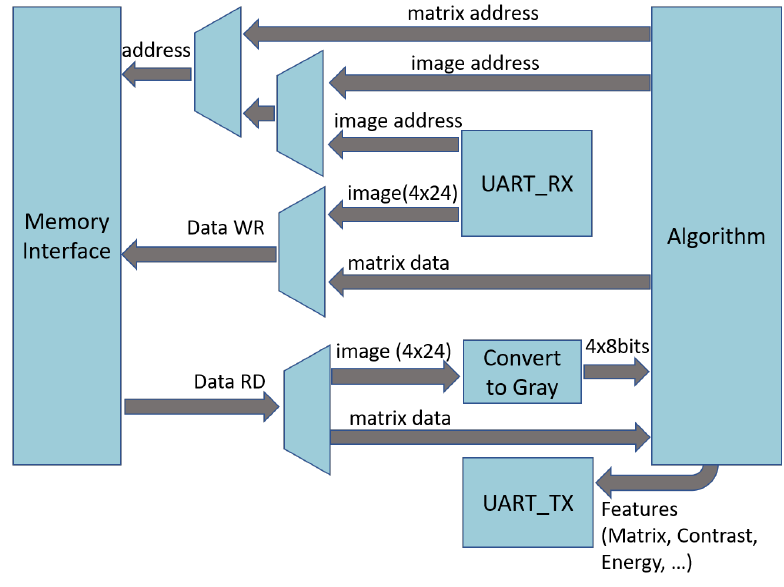
Figure 14. Simplified